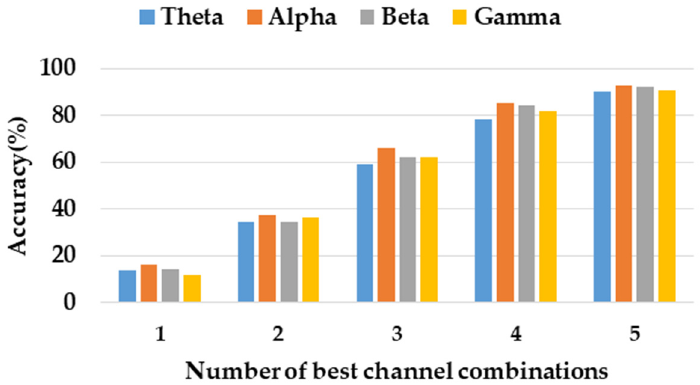
Figure 7. Average accuracy comparison of best channel combination options.